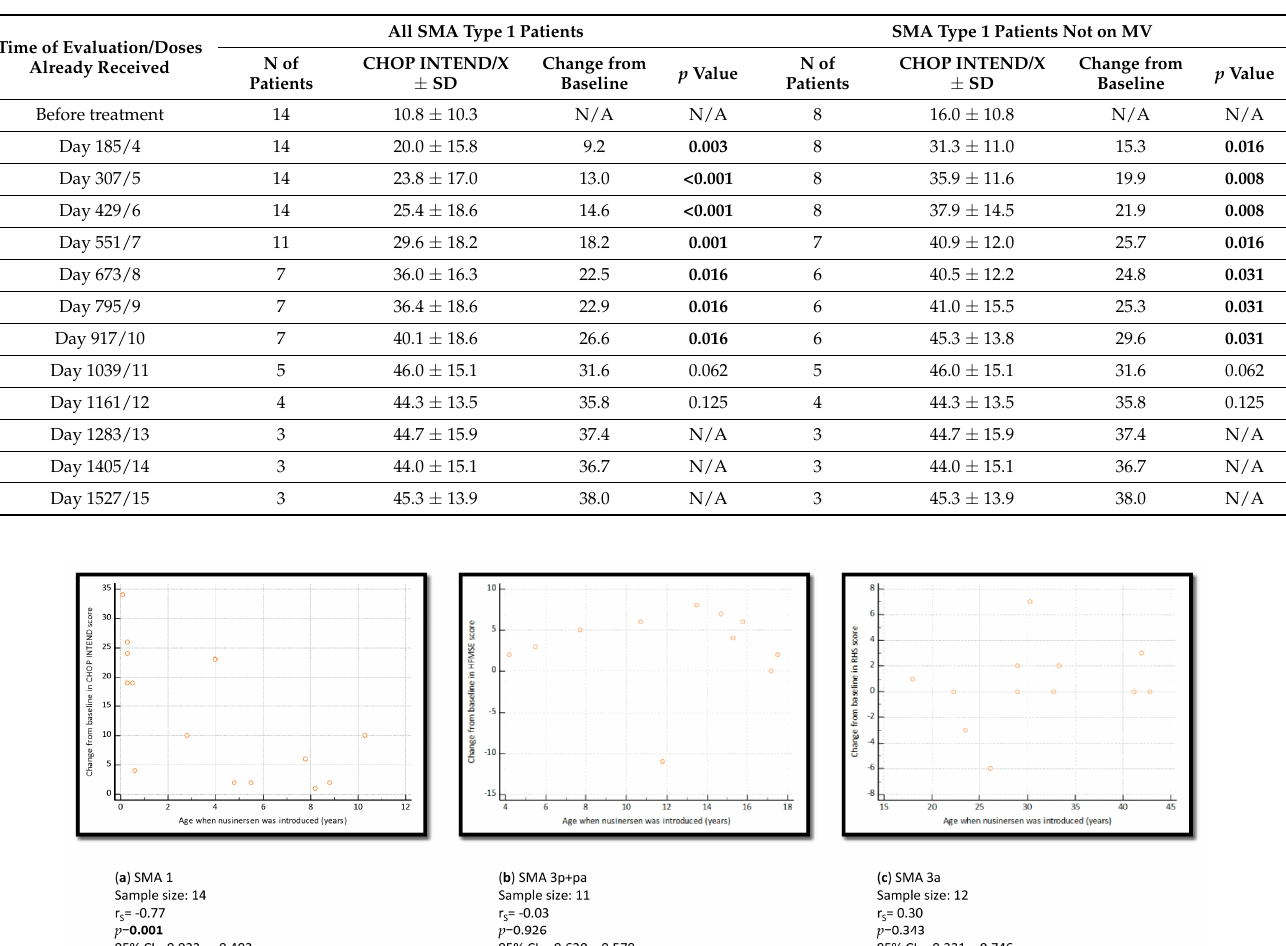
Table 3. The average CHOP INTEND scores by the time points of the nusinersen injection in SMA type 1 patients.